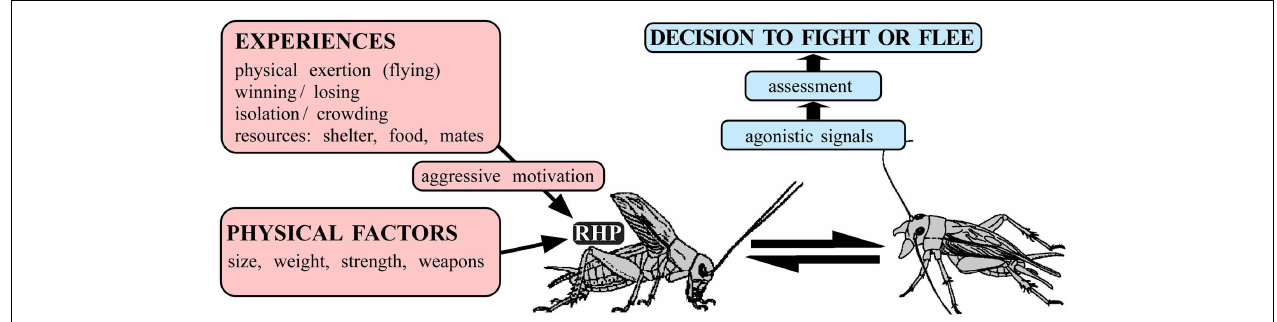
resources) that influence aggressive motivation. On confronting a competitor, agonistic signals exchanged during escalating ritualized fighting convey increasingly more accurate information on the individual’s RHP in order to assess whether it would be more opportune to persist in fighting or to